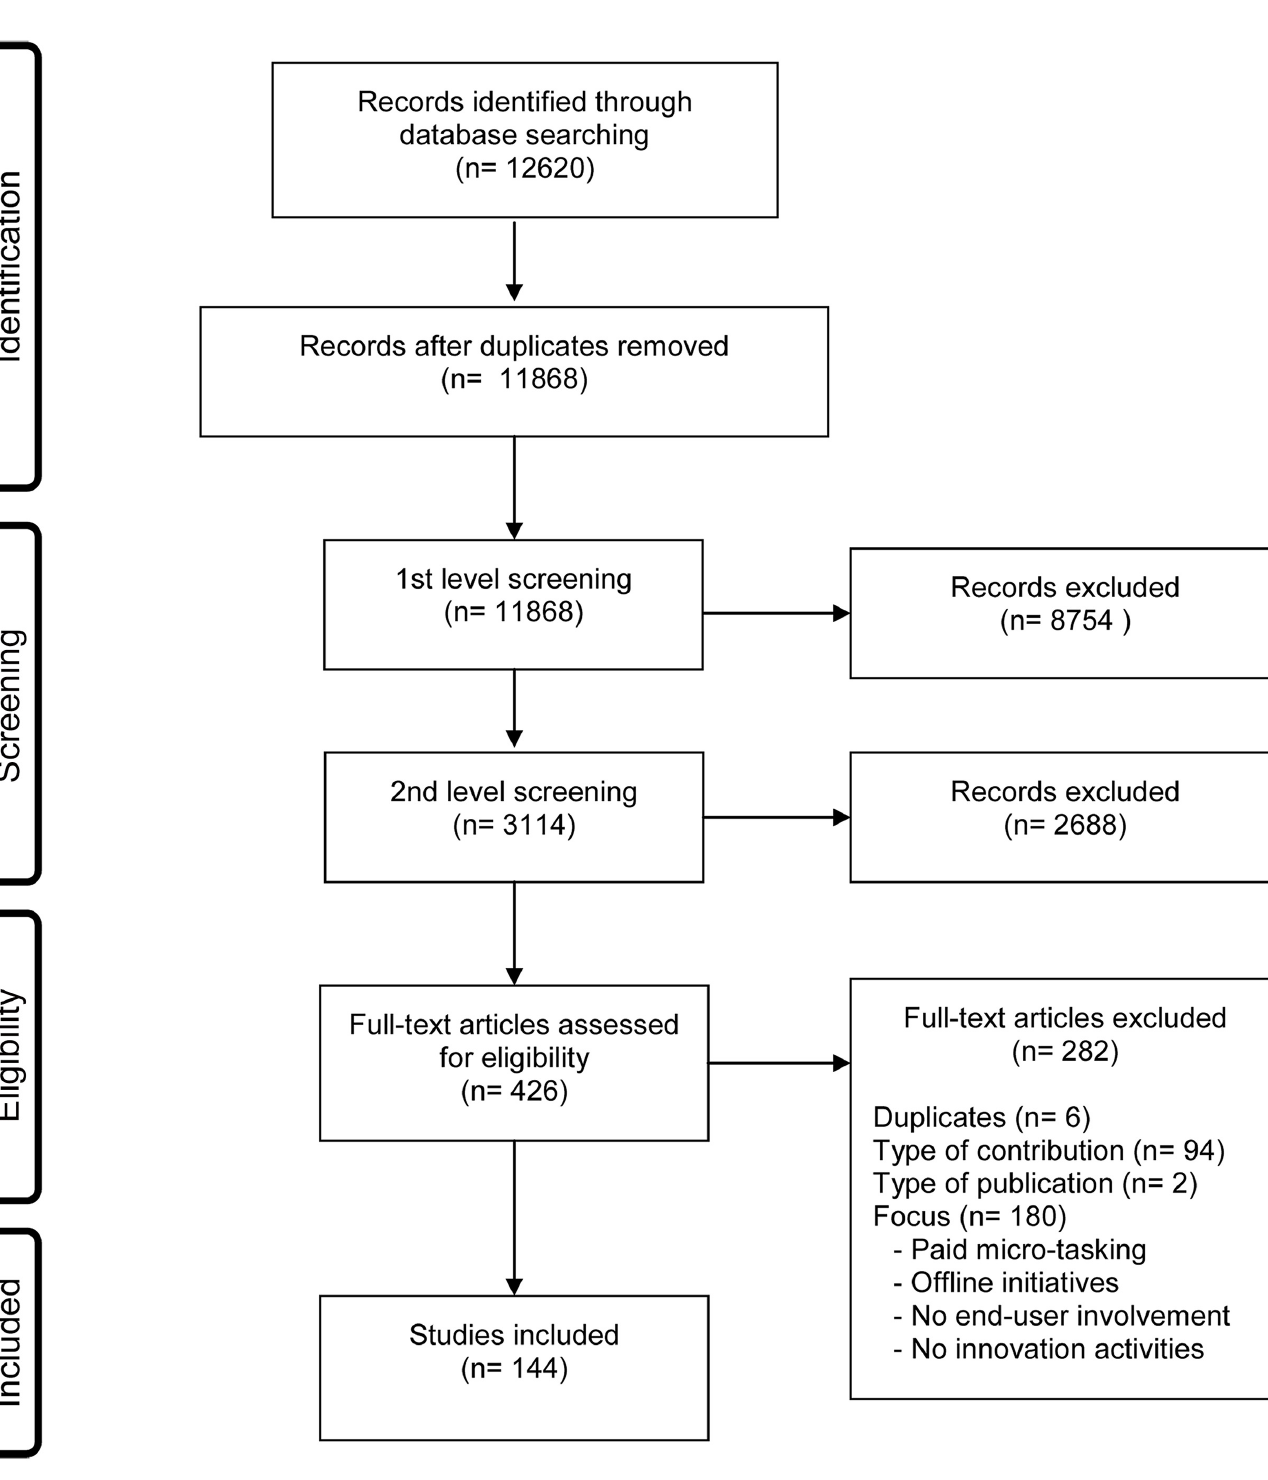
PLOS ONE | DOI:10.1371/journal.pone.0156175 June 7,